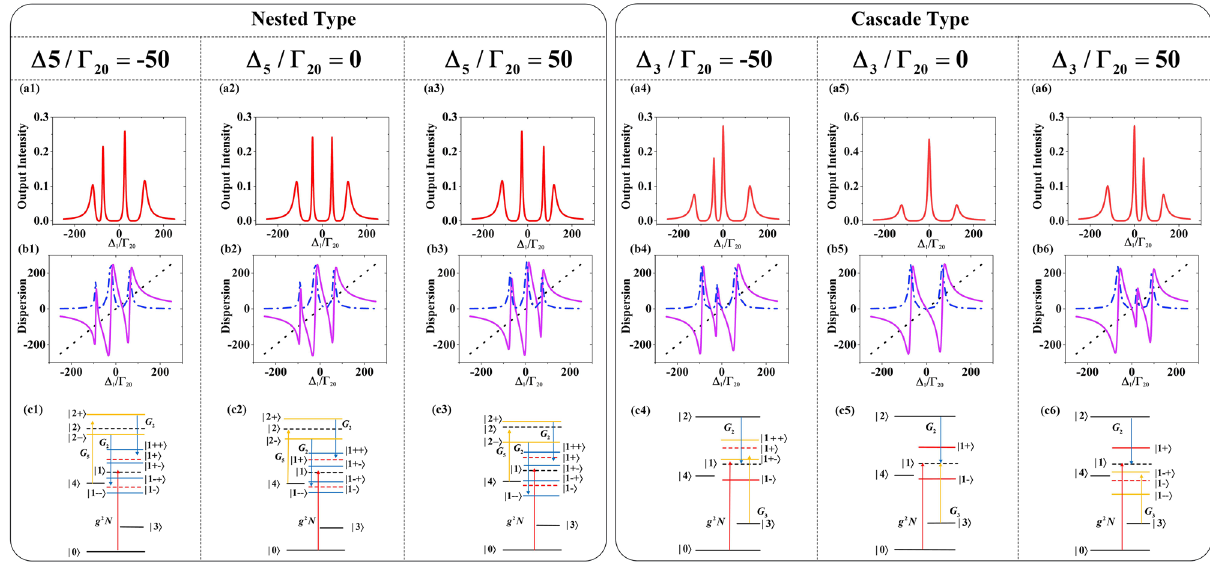
50 . ( a2 ) With Figure 2. ( a1 )–( a3 ) The nested FWM signal spectra when scan (cid:31) 1 . (a1) With � 5 /Ŵ 20 = − 0 (a3) With � 5 /Ŵ 20 50 . ( b1 )–( b3 ) Intracavity dispersion curves (solid curves), absorption curves � 5 /Ŵ 20 = = (dashed curves), and detuning (cid:31) 1 lines (dotted lines), corresponding to ( a1 )–( a3 ). ( c1 )–( c3 ) The dressed five-energy levels diagram, corresponding to ( a1 )–( a3 ). ( a4 )–( a6 ) The cascaded FWM signal spectra when 50 ( a5 ) With � 3 /Ŵ 20 0 . ( a6 ) With � 3 /Ŵ 20 50 . ( b4 )–( b6 ) Intracavity scan (cid:31) 1 . ( a4 ) With � 3 /Ŵ 20 = − = = dispersion and absorption curves corresponding to ( a4 )–( a6 ). ( c4 )–( c6 ) The dressed five-energy levels 50MHz , G 5 50MHz , 50MHz , G 3 diagram, corresponding to ( a1 )–( a4 ). The other parameters are G 2 = = = 0 MHz 0 MHz and (cid:31) ac (cid:31) 2 = = (cid:31) (cid:31) (cid:31) (cid:31) (cid:31) 2 . When probe field E (� 2 )/ 2 (� 2 ) 2 / 4 G 2 1 2 1 2 1 1 satisfies the four bright | +| + ± (cid:31) + −± = ± − − ± − − (cid:31) (cid:31) (cid:31) (cid:31) (cid:31) (cid:31) (cid:31) (cid:31) 0 , (cid:31) 1 0 , (cid:31) 1 0 and (cid:31) 1 0 , four state conditions (cid:31) 1 1 1 1 1 1 1 1 1 + + + + + + ++ = + + +− = − + −+ = − + − = splitting FWM peaks are obtained. These four secondary dressed energy states, corresponding to the four eigen- values, depicted in Fig. 2(c1), (c2) and (c3), which consistent with the four VRS peaks in Fig. 2(a1), (a2) and (a3). After clarifying that VRS peak will be split into four under nested interaction, we will discuss the positions changes of these peaks. The four FWM peaks shifting toward the negative region of scanning (cid:31) 1 in Fig. 2(a1),